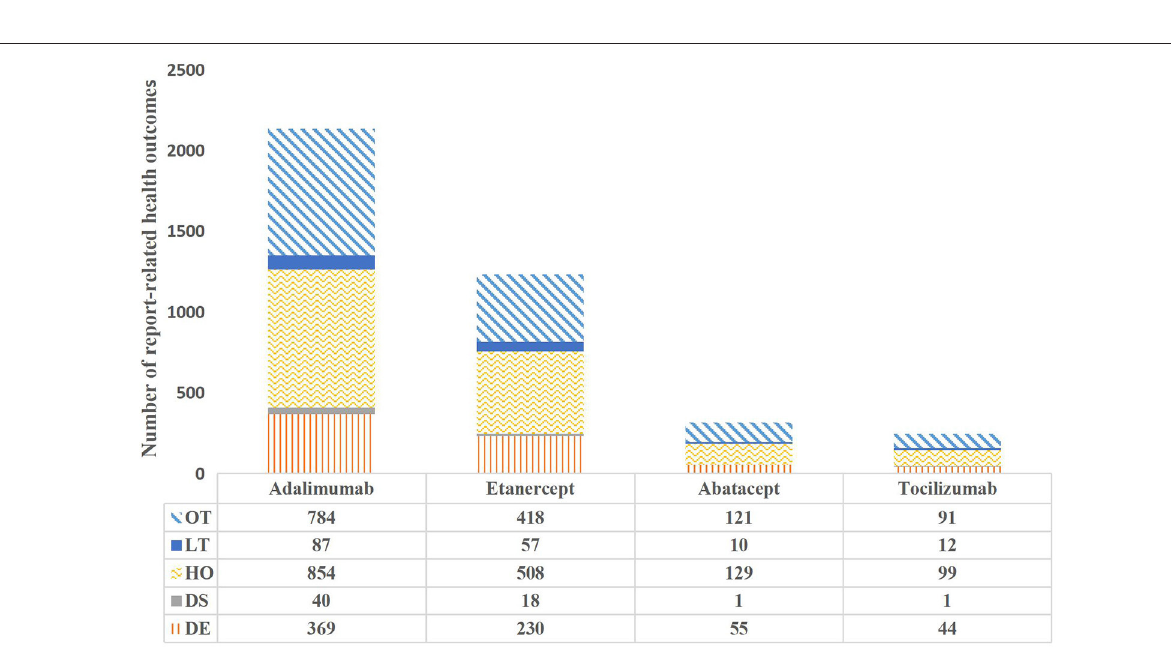
FIGURE 2 | Health outcomes in reports involving cardiotoxicity with the targeted therapies.